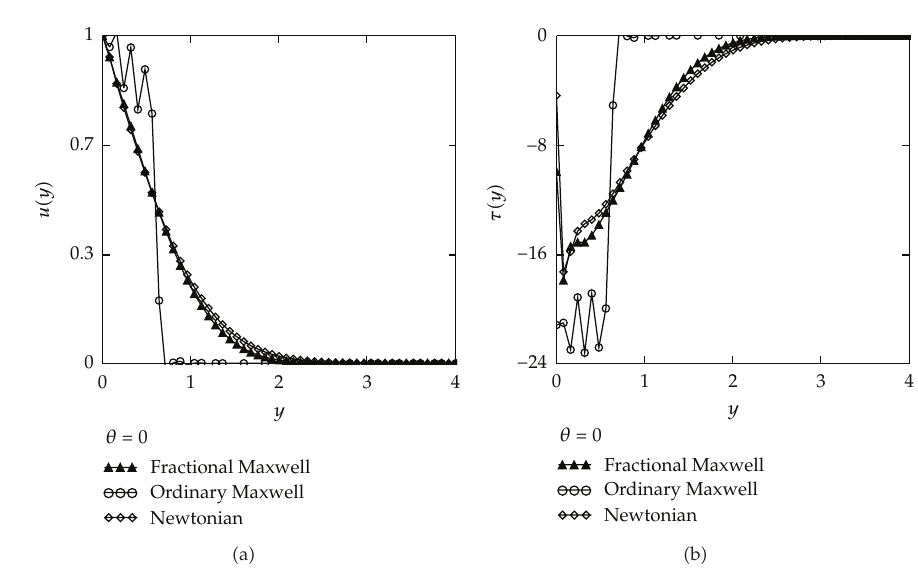
Figure 12: Profiles of the velocity field u (cid:4) y,t (cid:5) and the shear stress τ (cid:4) y,t (cid:5) for fractional Maxwell, ordinary Maxwell and Newtonian fluids, for U (cid:9) 1, y (cid:9) 1, ν (cid:9) 0 . 379, μ (cid:9) 33, λ (cid:9) 1 . 5, α (cid:9) 0 . 2, t (cid:9) 2s, and θ (cid:9) 0 . 0.